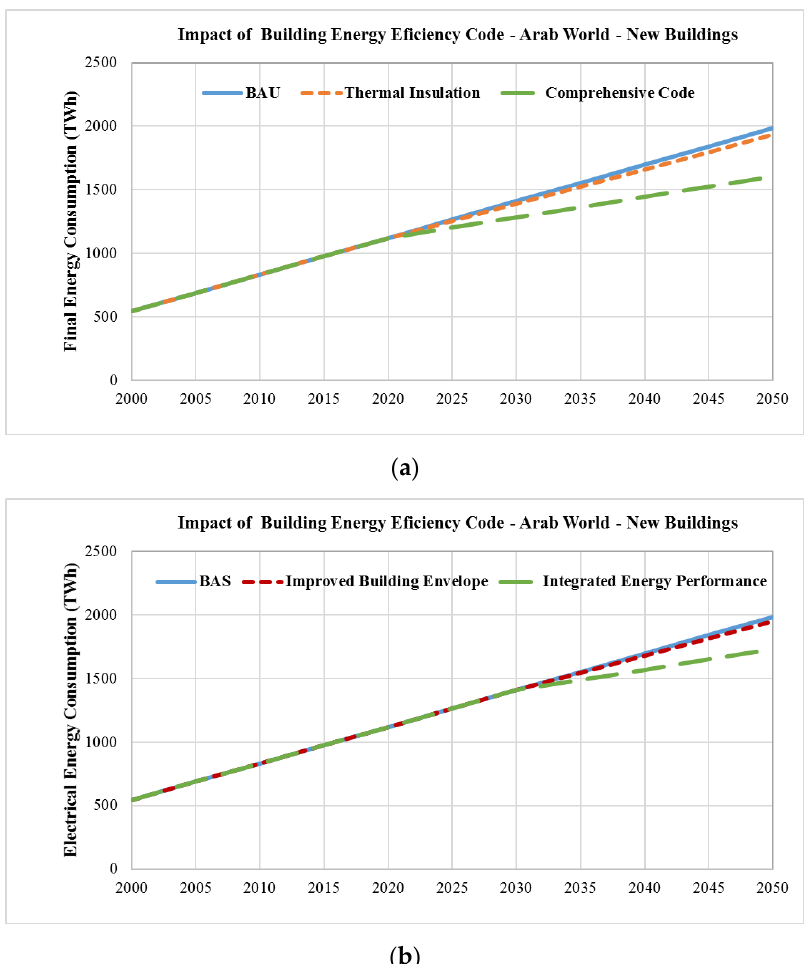
Figure 20. Impact on total final energy consumption of buildings due to implementation of energy e ffi ciency codes for new buildings in the Arab region with the start of implementation in ( a ) 2020 and ( b )